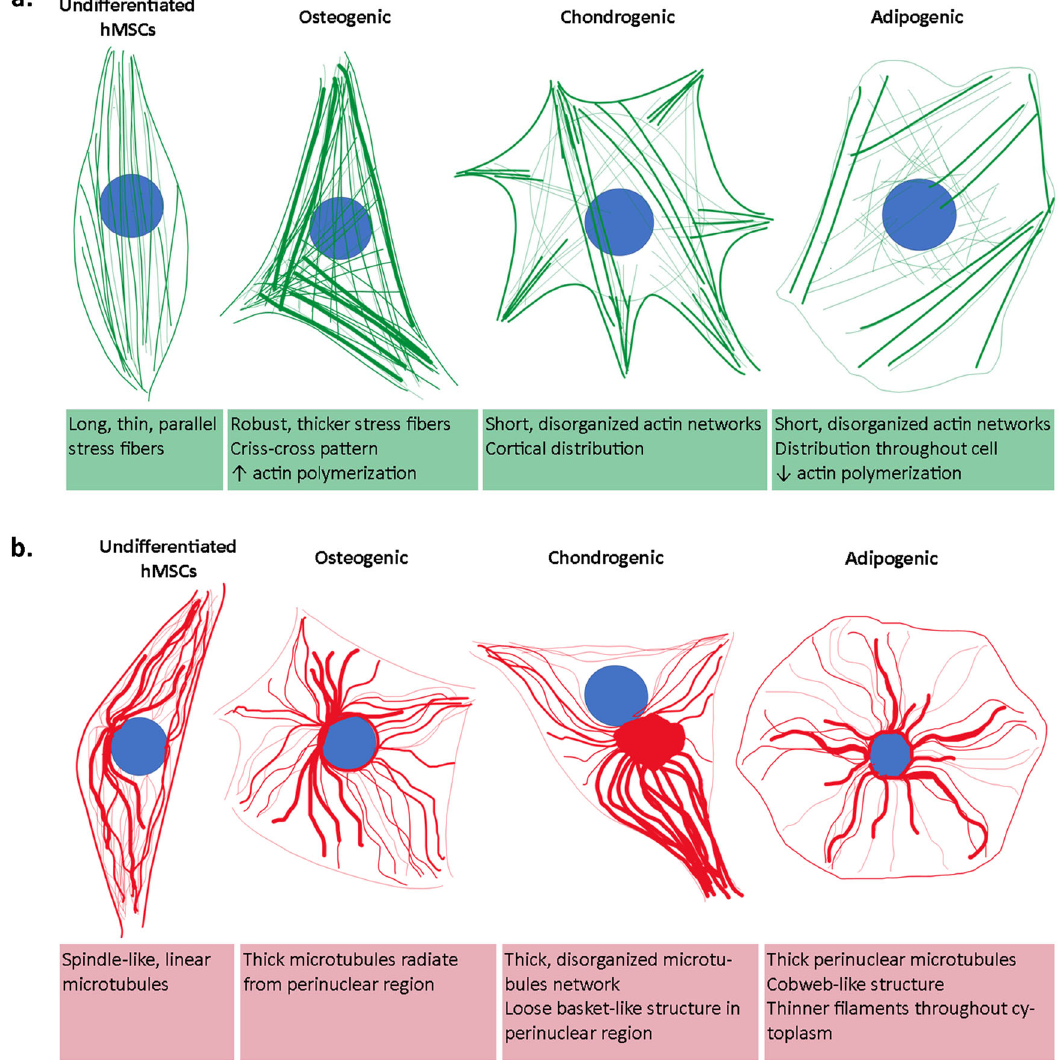
Fig. 3 The unique remodeling of the cytoskeleton represents the adaptiveness of stem cells to their environment, shaping their differentiation responses. Similar to tracking of genetic markers that provide a fi ngerprint in time for processes of stem cell differentiation 5,39 , remodeling of actin (green) ( a ) and tubulin (red) cytoskeleton ( b ) correlates to incipient differentiation of mesenchymal stem cells (hMSCs). Regulation of actin and tubulin de-/ polymerization results in speci fi c spatiotemporal patterns of their fi bers (shape, size, distribution, organization), re fl ecting the cells ’ adaptation of structure and function to their prevailing mechanical and biochemical milieux 4 (refs. 116; 130; 202; 203; 204; 19 ; and 117 ). In turn, changes in gene regulation and cytoskeletal remodeling scale up to create spatiotemporal patterns of tissues with speci fi c architectures and functions 205